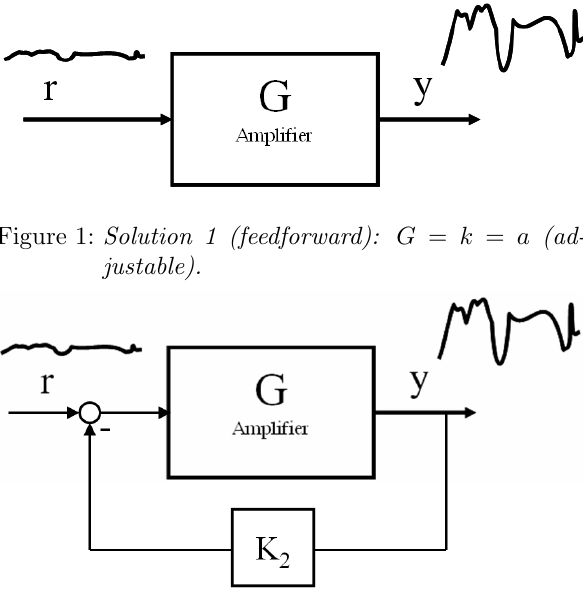
Figure 2: Solution 2 (feedback): G = k (large constant gain k > a ). K 2 = 1 /a